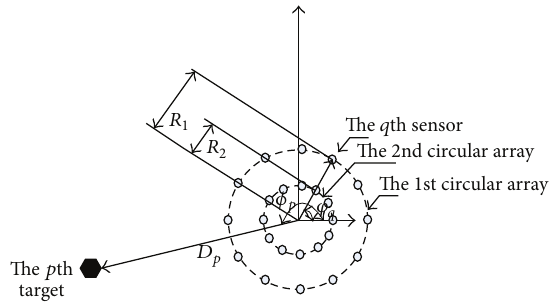
Figure 2: Geometry of two uniform circular arrays and targets.